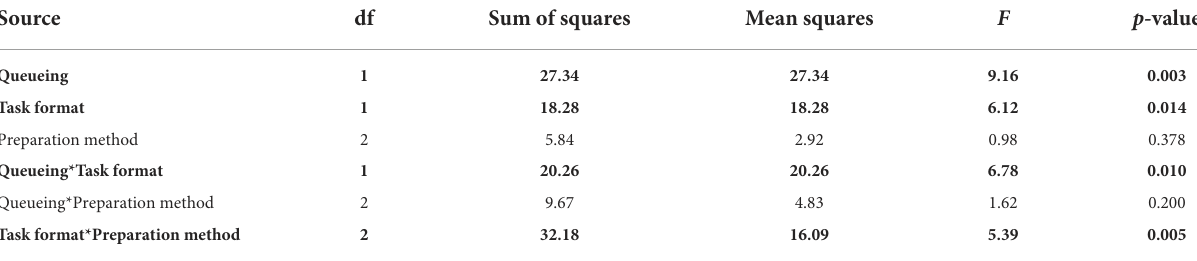
TABLE 4 Detailed ANCOVA model for the analysis of pizza liking scores ( F (9,259) = 3.77, p < 0.001). Source df Sum of squares Mean squares F p